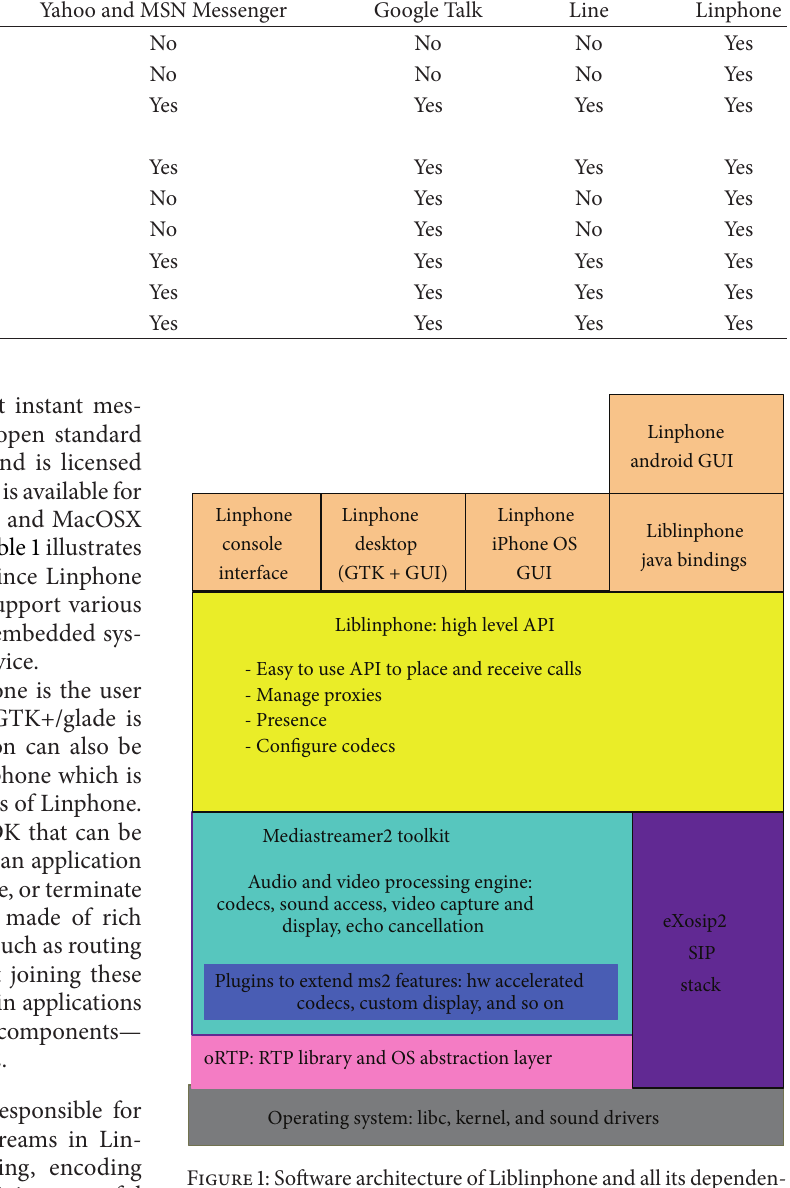
Figure 1: Software architecture of Liblinphone and all its dependen- cies